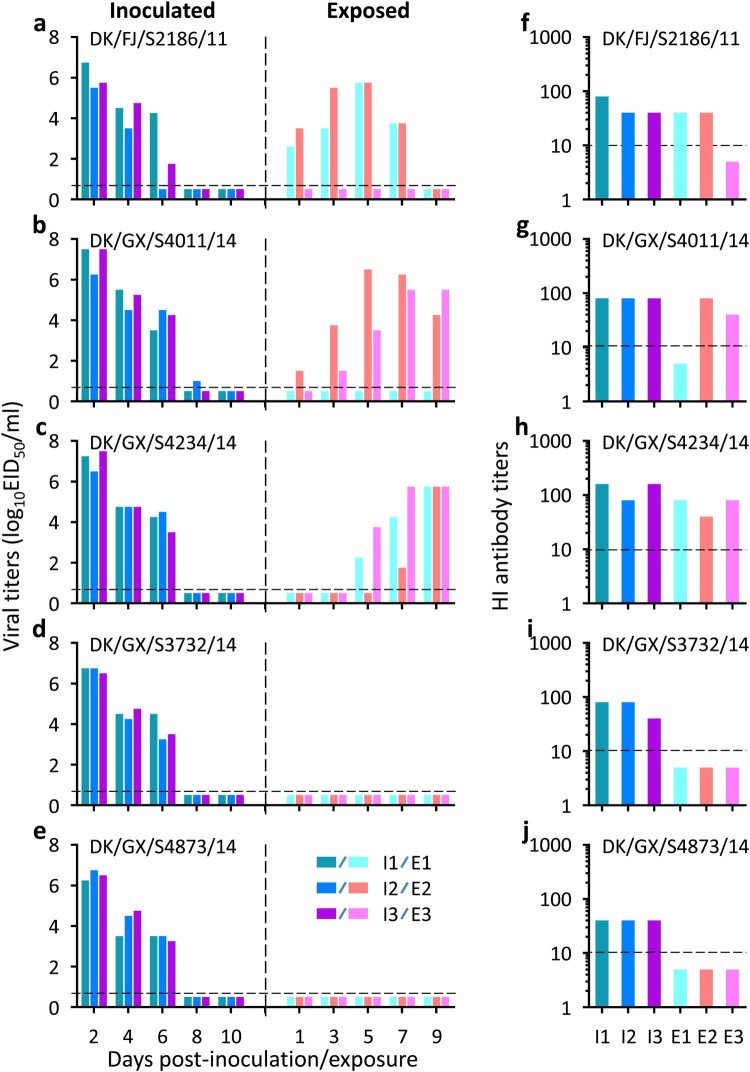
Respiratory droplet transmission of H3N2 avian influenza viruses in guinea pigs. Groups of three guinea pigs were inoculated intranasally with 106 EID50 of test virus, and 24 h later, three naïve guinea pigs were introduced into neighbouring cages. Nasal washes were collected every 2 days from all guinea pigs beginning on Day 2 post-inoculation (p.i.) or Day 1 post-exposure (p.e.) for detection of virus shedding, and seroconversion of the animals was confirmed by use of a hemagglutinin inhibition (HI) test. Each colour bar in panels a–e represents the virus titre from an individual animal, and each colour bar in panels f–j represents the HI antibody titre from an individual animal. The horizontal dashed lines indicate the lower limit of detection.